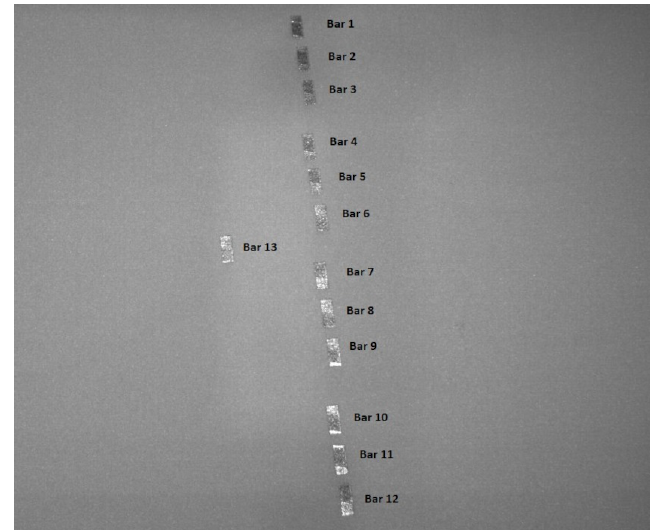
Figure 7. The powder-bed image of layer 20 after laser exposure.